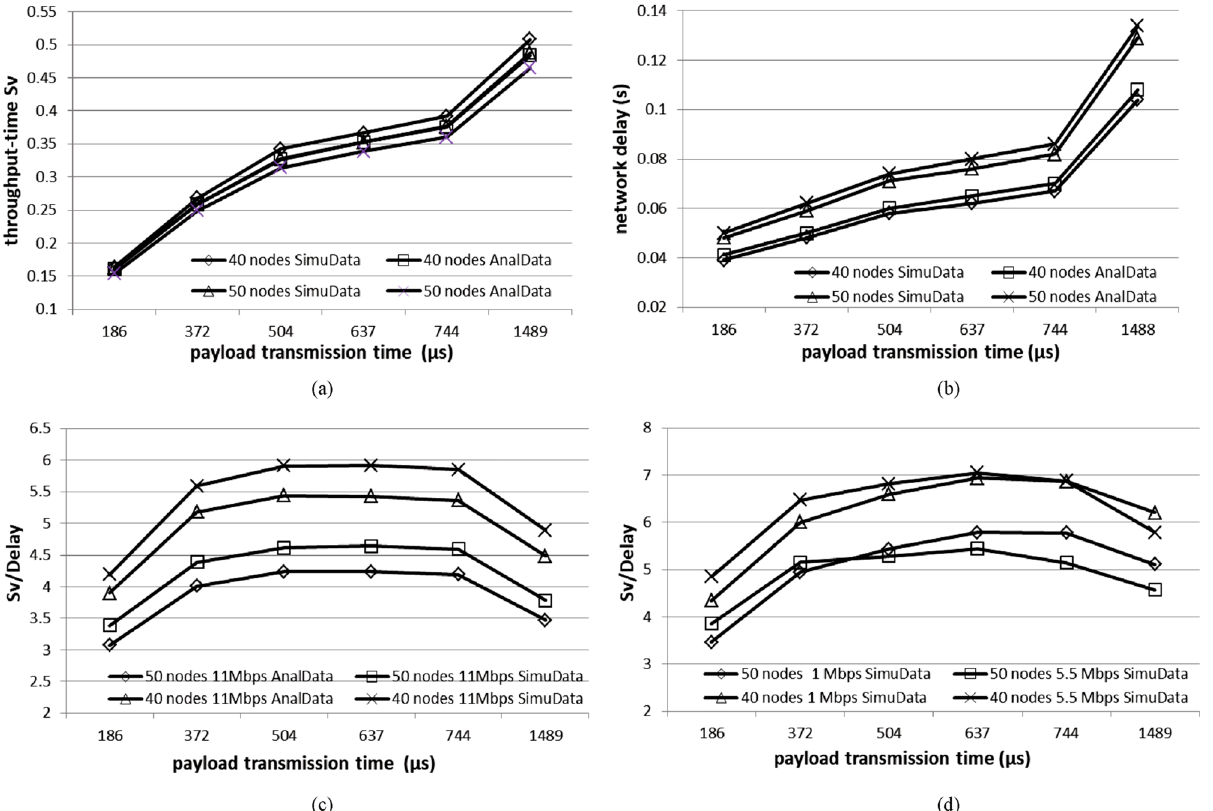
Figure 2. Network performance with different payload transmission time at data rate 11 Mbps. ’SimuData’ means simulation results; ’AnalData’ means analysis results. The network is composed of 40 nodes and 50 nodes. The simulation data of throughput-time performance and network delay performance are close to the analysis data in ( a , b ). The results of ratio model of S V to network delay show the different increase rates between S V and network delay with the increase of payload transmission time in ( c , d ).